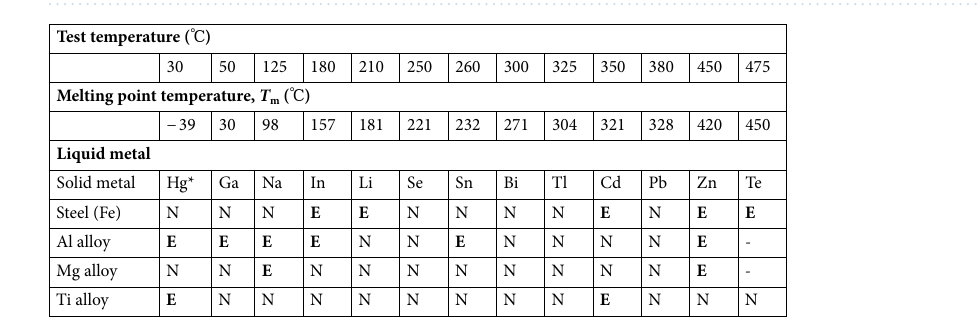
Table 1. A specificity data of LME. This table is taken from Rostoker et al. 10 and modified. See text. Hg* 3% Zn amalgam. E : embrittlement with no apparent prior plastic deformation (probably GB cracking). N: non- embrittlement. Steel (Fe): The steel was an alloy constructional type quenched and tempered to Rc 45 hardness. Al, Mg, and Ti alloys: The test was done using at least two high-strength commercial alloys for each metal.